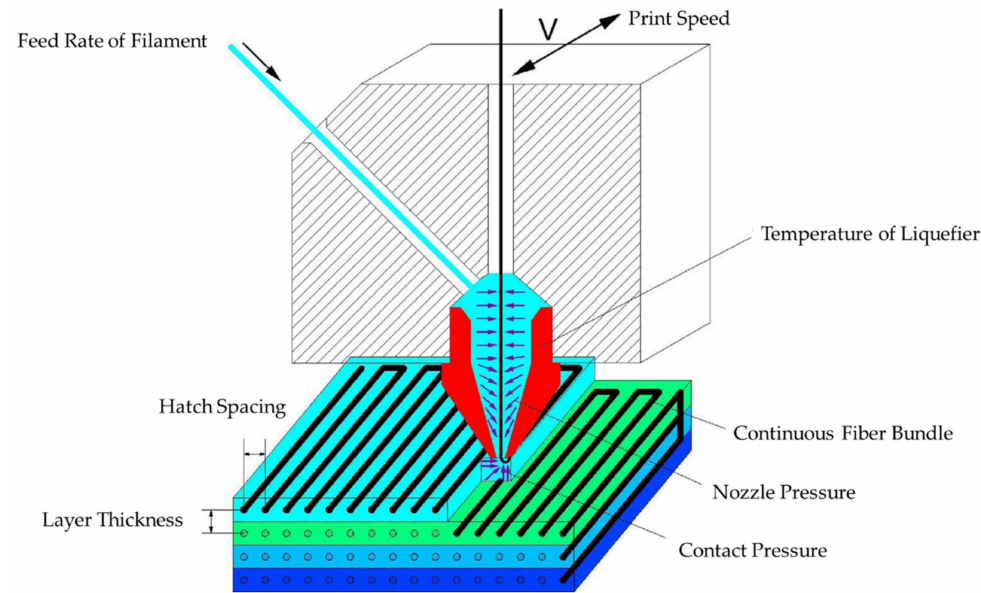
Figure 7. FDM 3D printing apparatus with continuous fibers. Reproduced with permission from [63], Elsevier,